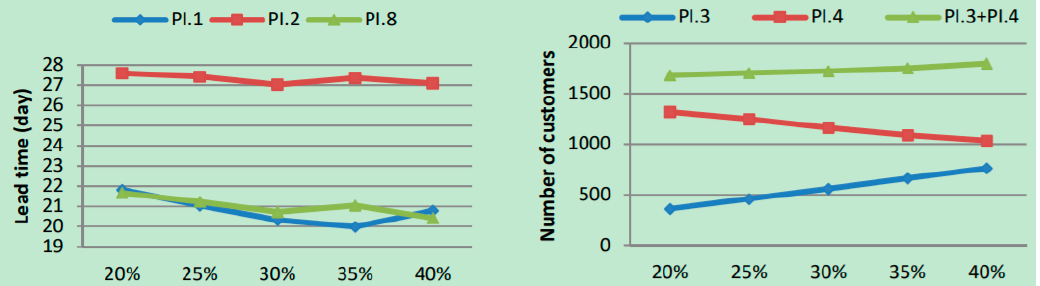
Figure 19. Effects of different acceptance rates on lead time and number of customers.